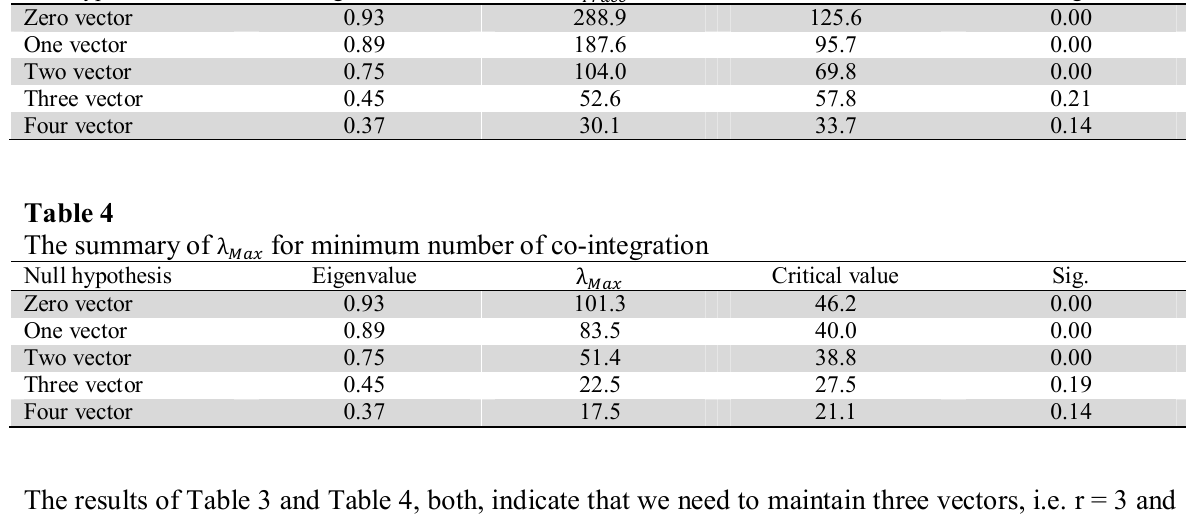
Critical value Sig.